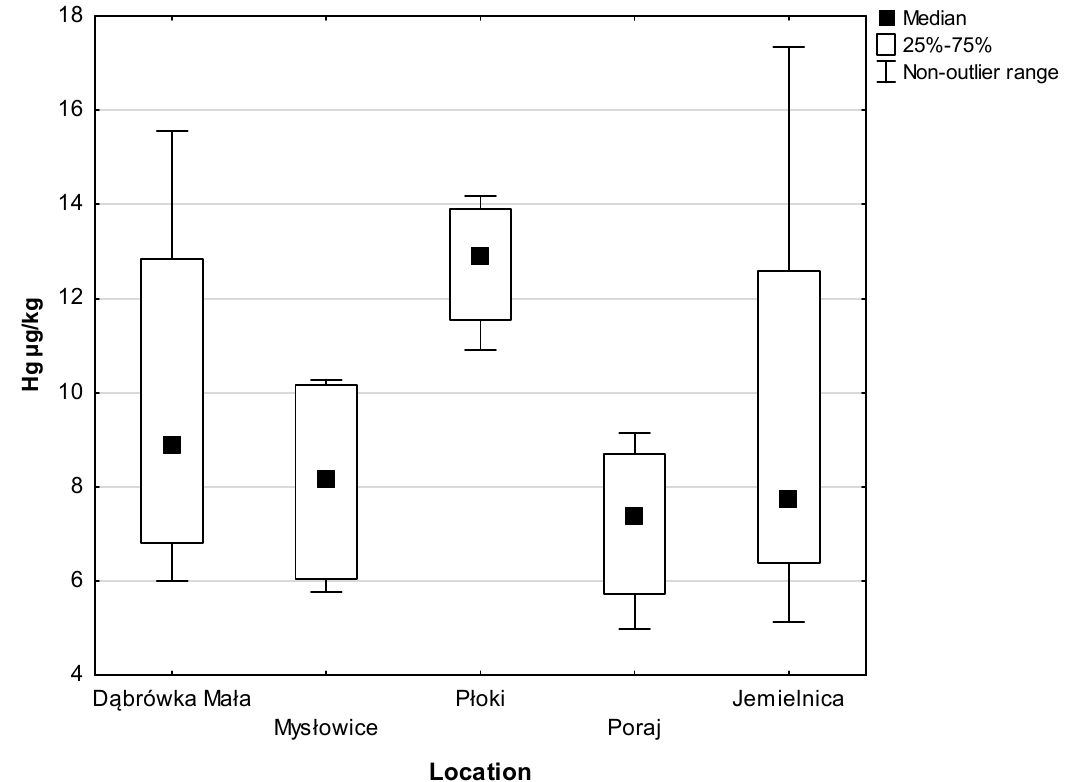
Figure 3. Hg concentration in spices grown independently in different locations in southern Poland, µg/kg.